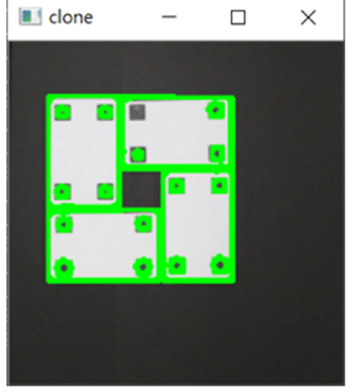
Figure 28. Boxing objects.